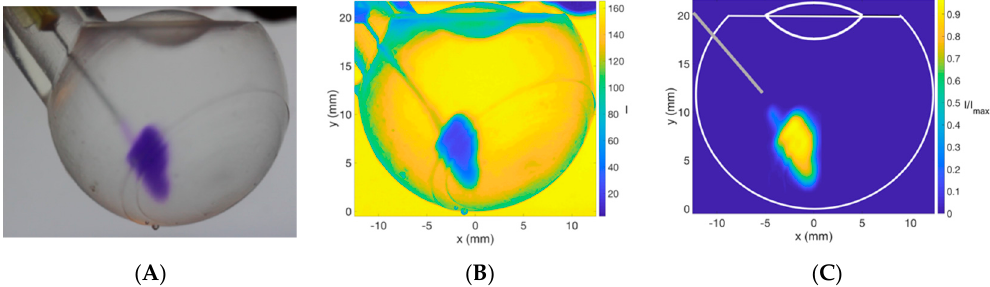
Figure 2. Steps taken in digital image processing. Side view photograph of injected Coomassie blue solution into sodium hyaluronate (HA, 3.0 mg/mL) with a Re value of 145. Raw image ( A ) converted into red, green, and blue colors ( B ) after background subtraction ( C ) using MATLAB software.